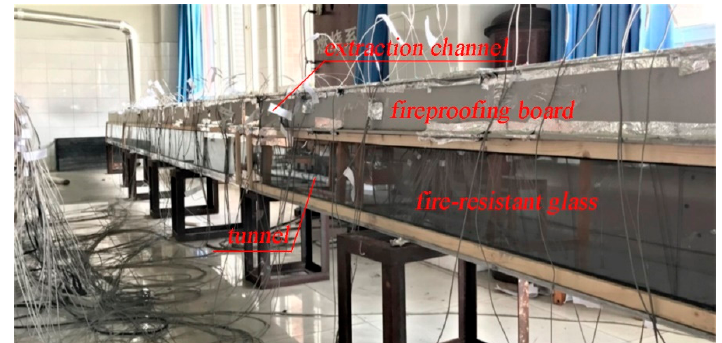
Figure 4. Model tunnel